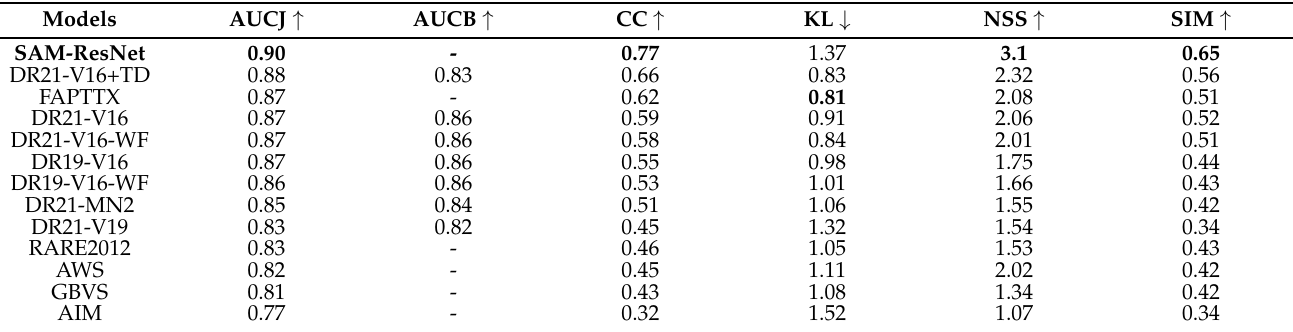
Table 7. OSIE dataset. DeepRare2021 (VGG19: DR21-V19, VGG16 without faces: DR21-V16-WF, VGG16 with faces: DR21-V16, MobileNetV2: DR21-MN2), DeepRare2019 (VGG16: DR19-V16), DeepRare2019 (VGG16 without faces: DR19-V16-WF, VGG16 with faces: DR19-V16), and